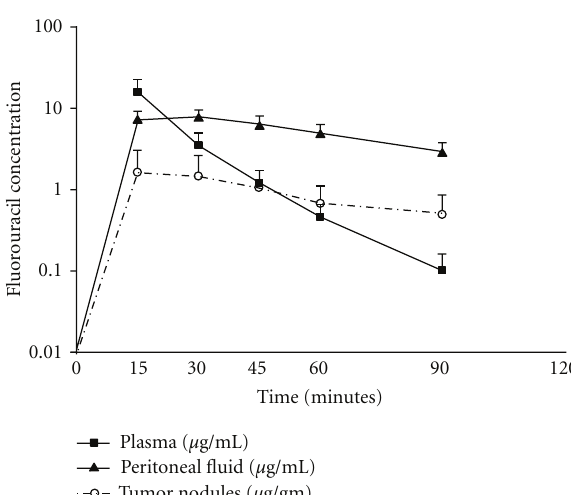
Figure 4: 5-Fluorouracil concentrations in plasma, peritoneal fluid, and tumor nodules after intravenous administration during hyperthermic intraperitoneal chemotherapy procedure